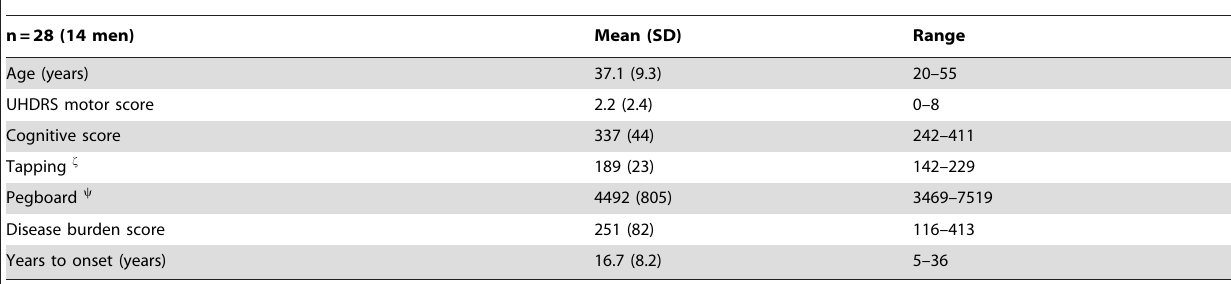
Table 1. Clinical characteristics of PreHD